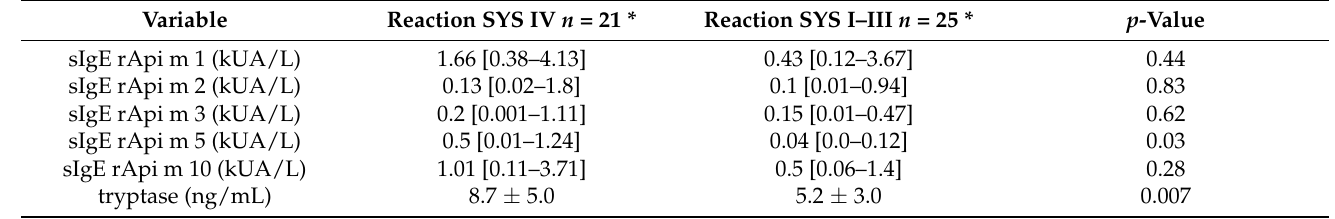
Table 5. Comparison of serum levels of specific IgE against bee venom allergen molecules and basal tryptase among patients with reactions to SYS IV and SYS I, II, or III.